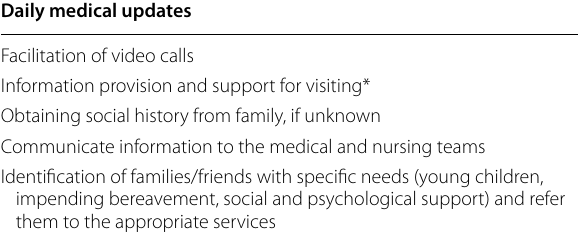
Table 1. Family Liaison Team